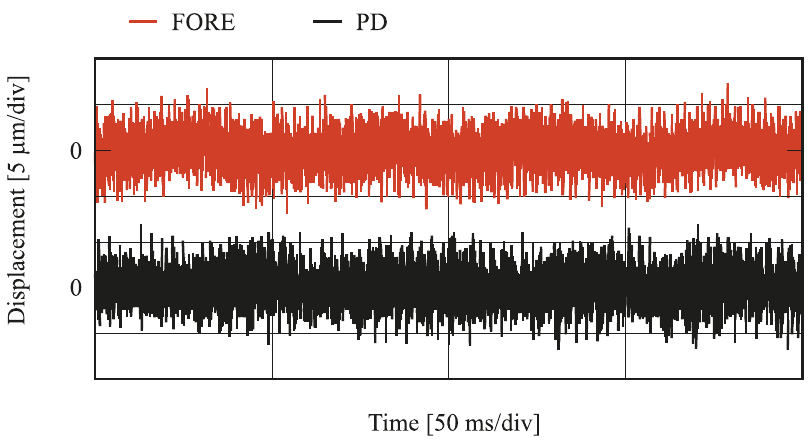
Figure 16. Comparison in time history in the steady state. FORE-controlled: blue line; PD-controlled: black line.